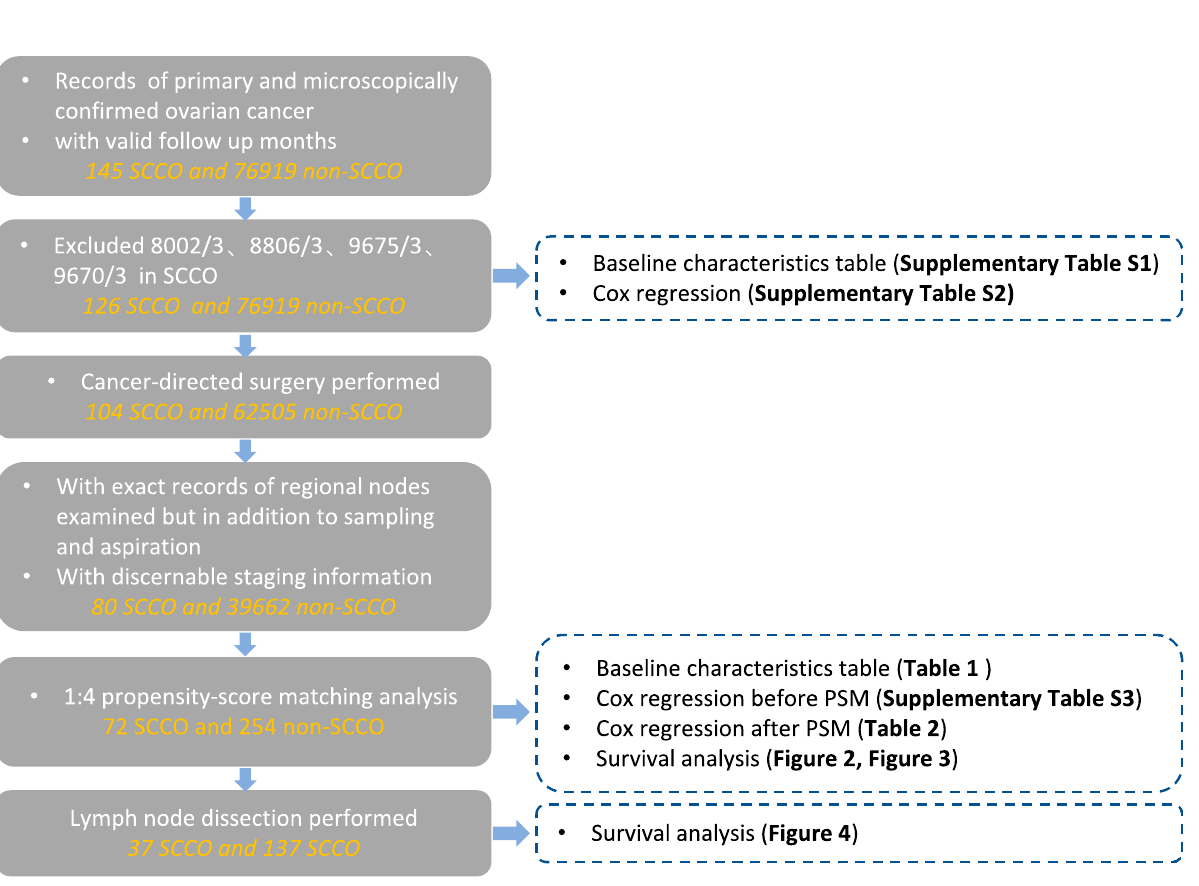
Figure 1. Flow chart of data selection.